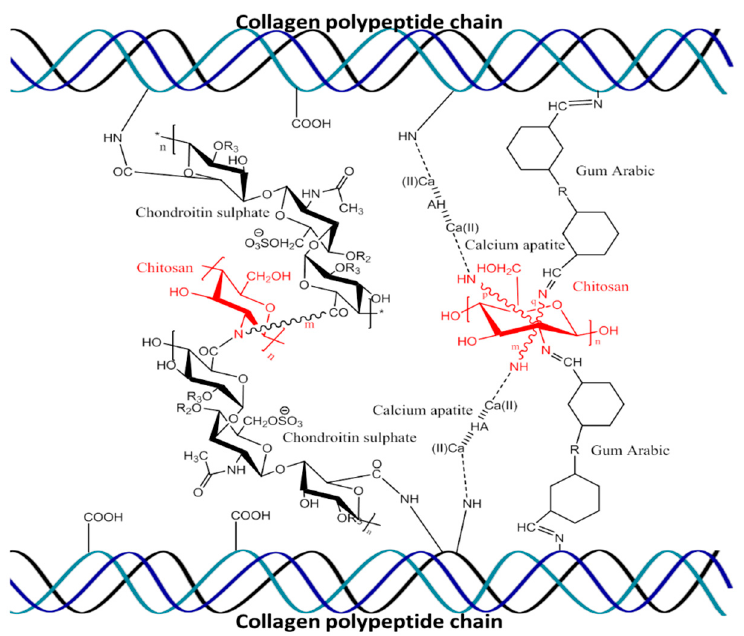
Figure 1. Schematic representation of molecular interactions of chitosan, gum Arabic, hydroxyapatite, and chondroitin sulfate with collagen polypeptides.